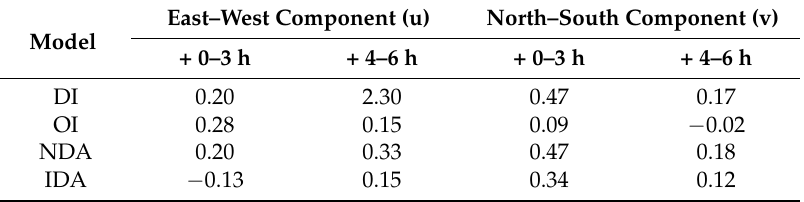
Table 2. Averaged DASS values for surface velocity components during forecasting